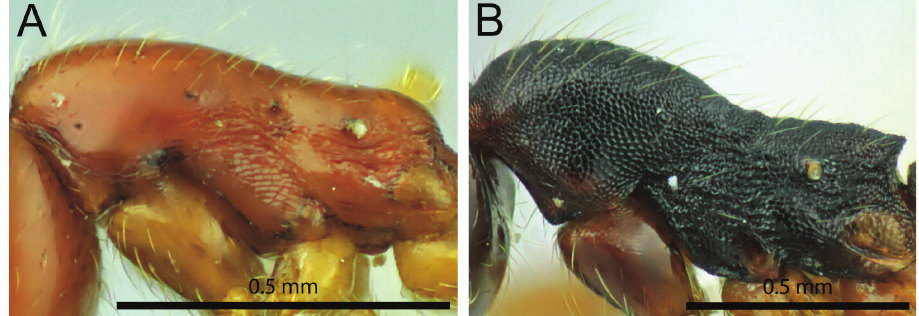
Figure 2. Mesosoma in profile. A A. longicephalus Jaitrong & Yamane B A. pinkaewi Jaitrong & Yamane. Images are from Jaitrong and Yamane